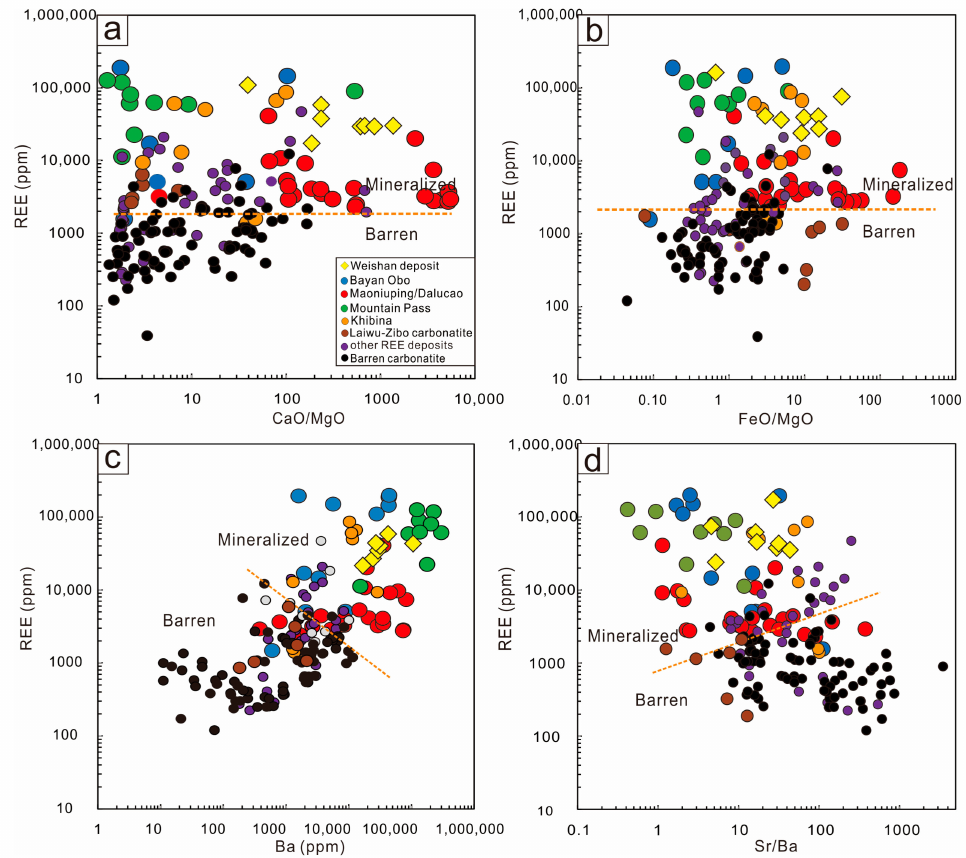
Figure 9. ( a ) REE–(CaO / MgO) and ( b ) REE–(FeO / MgO) diagrams for examples of carbonatites. These data indicate that REE enrichment is unrelated to the type of carbonatite and its major element composition (most data are from Table 4 in [12,63]). ( c ) REE–Ba and ( d ) REE–(Sr / Ba) diagrams for the Weishan deposit and other examples of mineralized and barren carbonatites. Carbonatites associated with giant CARDs have extremely high Ba and REE contents, positive Ba–REE correlations, and negative (Sr / Ba)–REE correlations (data from